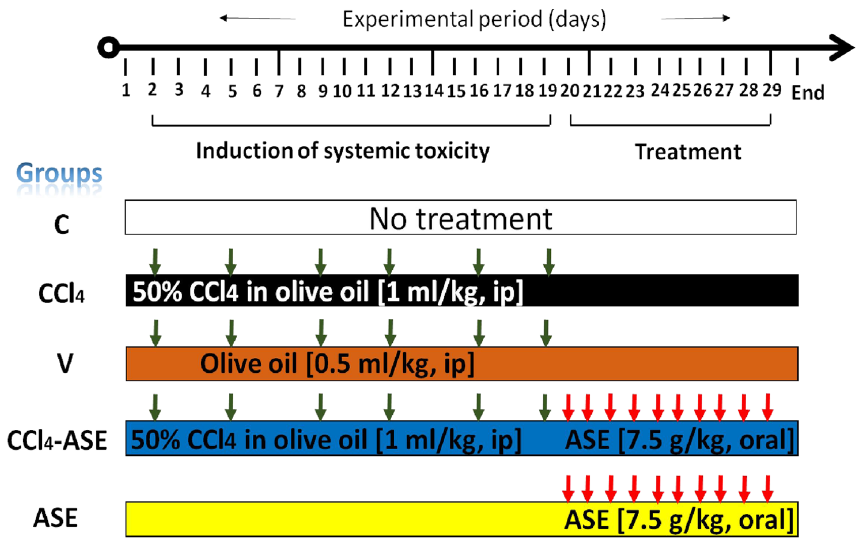
Figure 8. Experimental design with animal group treatments. Induction of systemic toxicity was performed by intraperitoneal (ip) injection of rats with CCl 4 for 3 weeks (twice/week). Then rats were left without treatment for the period from day 20 to day 29. Animals in the CCl 4 -ASE group were orally gavaged with ASE for 10 days following induction of systemic toxicity. The study includes three control groups of animals, the untreated animals (C group, received no treatments in all the study period), animals in the V group that were injected for 3 weeks (twice/week) with the vehicle of CCl 4 (olive oil, no treatment from day 20 to day 29), as well as those orally administered ASE for 10 days (ASE group, no treatment from day 0 to day